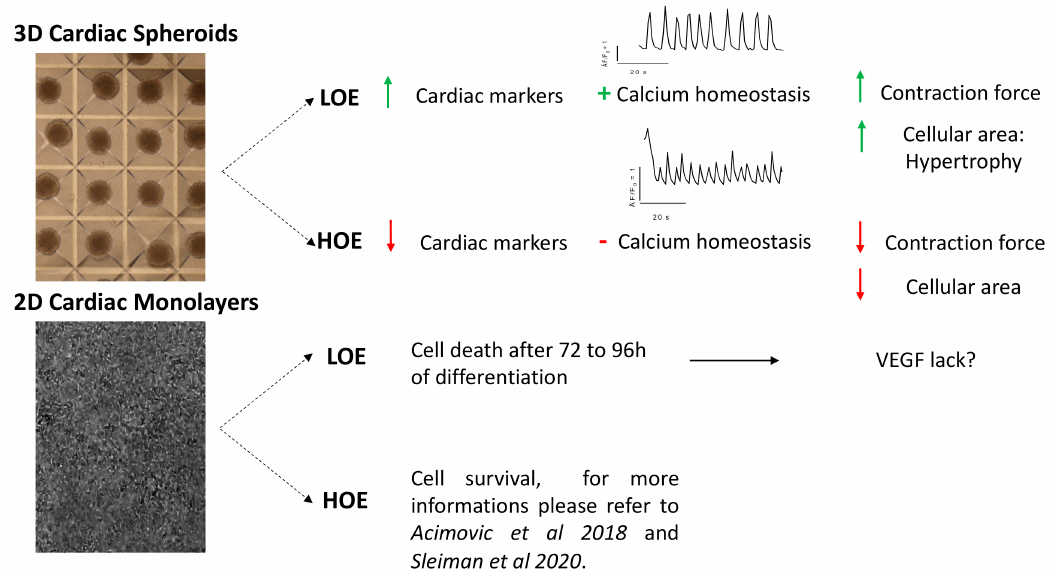
Figure 8. Schematic conclusion representing the main findings. 3D cardiac spheroids differentiated under LOE present a higher expression of cardiac markers, mature Ca 2+ homeostasis parameters, higher contraction force and increase of cell area compared to 3D cardiac spheroids differentiated under HOE conditions. 2D cardiac monolayers differentiated under LOE die after 72 to 96 h of